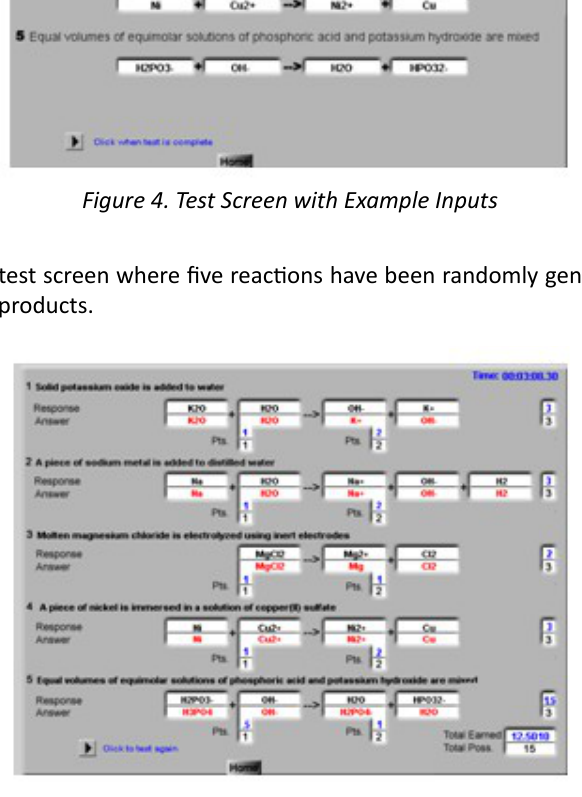
Figure 5. Test Screen with Completed